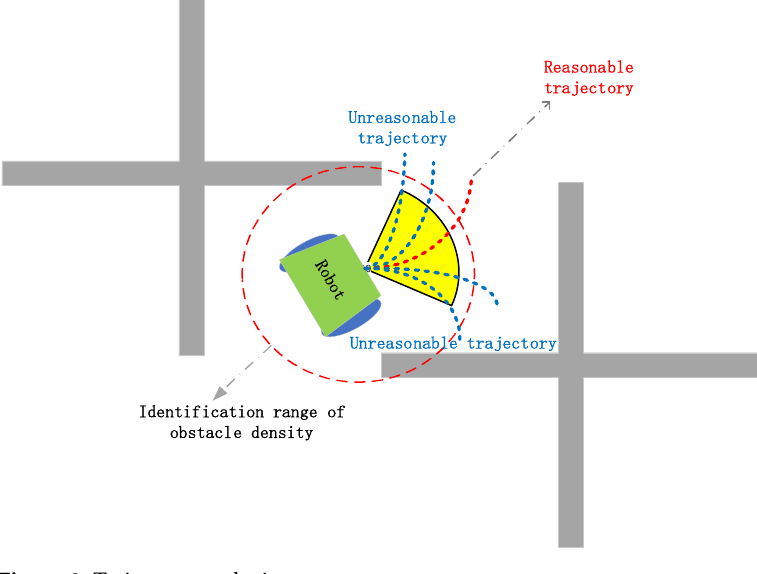
Figure 8. Trajectory analysis.